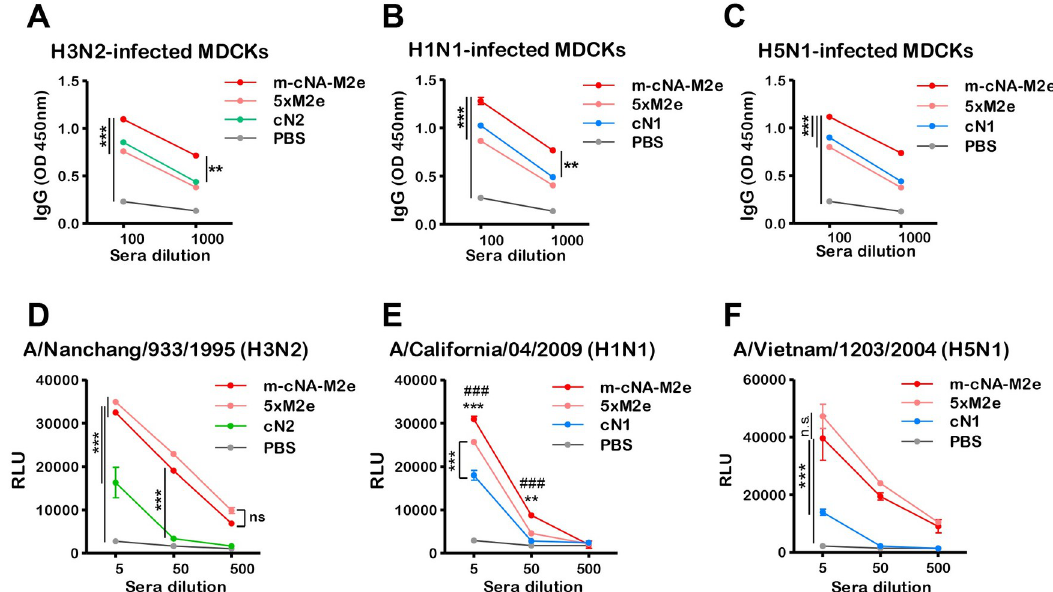
Fig 7. IgG antibodies recognizing cell surface viral antigens and ADCC functional activities by m-cNA-M2e VLP-vaccination. (A-C) IgG antibodies recognizing cell surface viral antigens. MDCKs were infected with influenza A viruses (A/Nanchang/933/1995 H3N2, A/California/04/2009 H1N1, and rgA/Vietnam/1203/2004 H5N1). The levels of IgG binding to virus antigens expressed on MDCKs were determined by ELISA. Binding reactivity of immune sera to H3N2- (A), H1N1- (B), H5N1- (C) infected MDCKs. (D-F) ADCC reporter assays of antisera from immunized mice, against MDCK target cells infected with A/Nanchang/933/1995 (H3N2) (D), A/California/04/2009 (H1N1) (E), and rgA/VN/1203/2004 H5N1 (F). Subsequently, the ADCC reporter assay was performed using Jurkat effector cells expressing mouse FcrRIII, and the relative luminescence unit (RLU) was measured. The statistical significances were performed with two-way ANOVA with Bonferroni posttest and indicated as �� , P < 0.01; ��� ,### , P < 0.001 (compared among the m-cNA-M2e and PBS or monomeric cN control groups); ns, no significant difference between two compared groups.